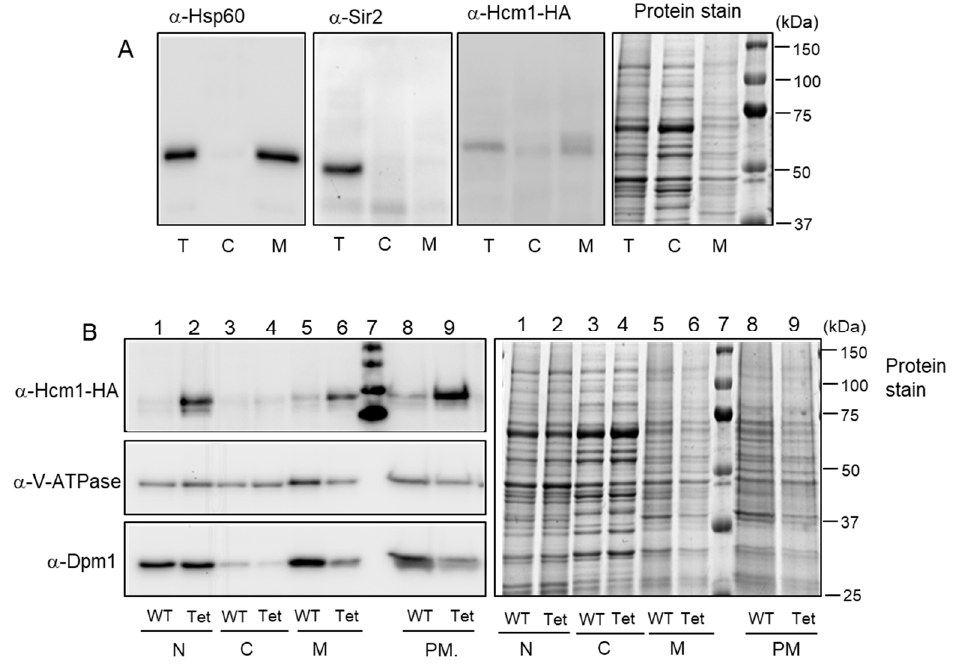
Figure 2. Analysis of Hcm1 localization by cell fractionation followed by sucrose-gradient centrifugation. ( A ) WT ( HCM1-HA ) cells growing exponentially were analyzed by Western blot of Hsp60 (mitochondrial protein), Sir2 (nuclear protein), and Hcm1 from total extracts and cytosolic and mitochondrial-enriched fractions. ( B ) WT ( HCM1-HA ) and Hcm1-overexpressing ( tetHCM1-HA , labeled as tet) cells growing exponentially were fractionated in nuclear, cytosolic, and mitochondrial- enriched fractions (lanes 1 to 6). Mitochondrial-enriched fractions were subjected to a sucrose gradient centrifugation to obtain purified mitochondria (lanes 8 and 9). All samples were analyzed by Western blot with anti-HA (Hcm1), V-ATPase (vacuolar ATPase), and Dpm1 (ER dolichol-phosphate mannosyltransferase subunit 1 protein). Protein stain with Brilliant Coomassie Blue is shown as a